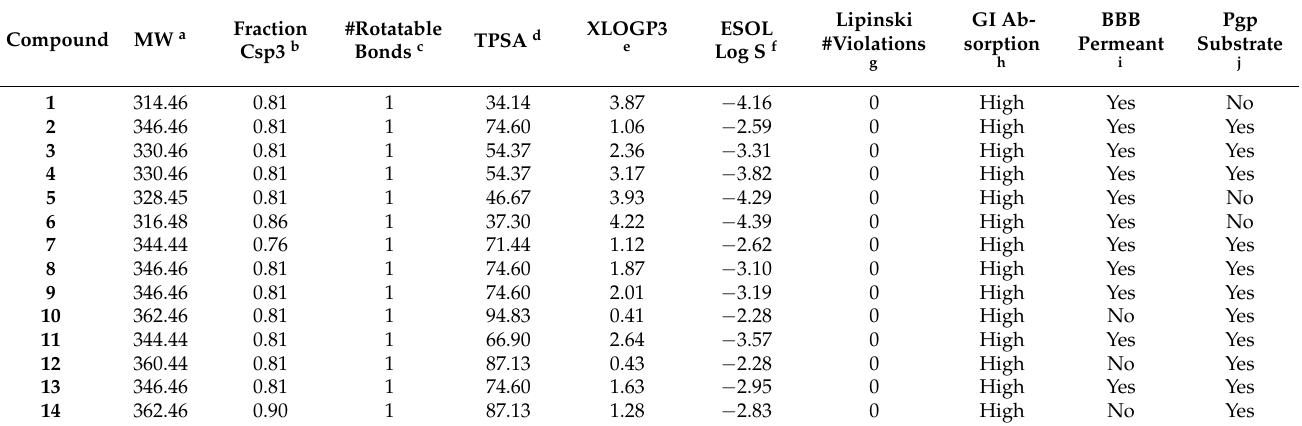
Table 2. Selected parameters obtained by the SwissADME web